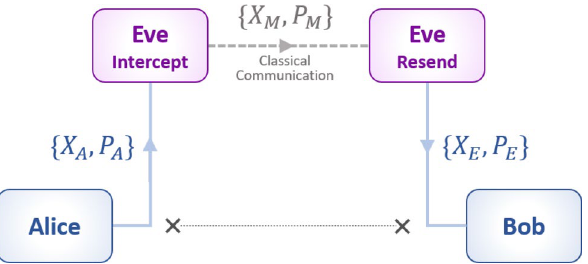
Figure 1. Scheme for saturation attack. Eve intercept intercepts Alice’s Gaussian modulated signal of quadratures { X } and shares her measurement results { X A , P A displaced signal of quadrature { X E , P E } is measured by Bob homodyne